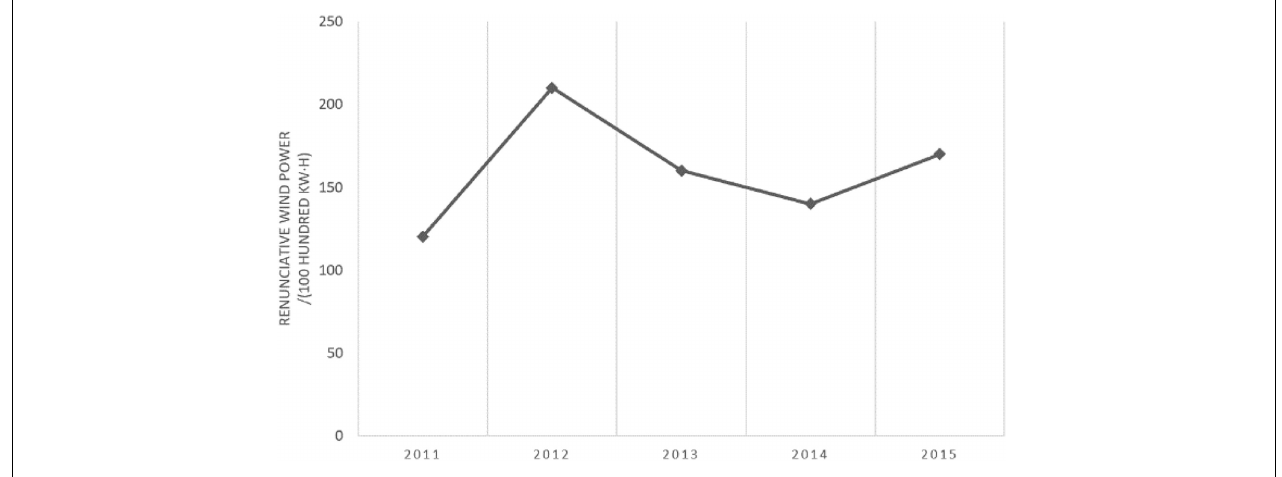
FIGURE 2 | The statistics on abandoned wind power nationwide between 2011 and 2015.